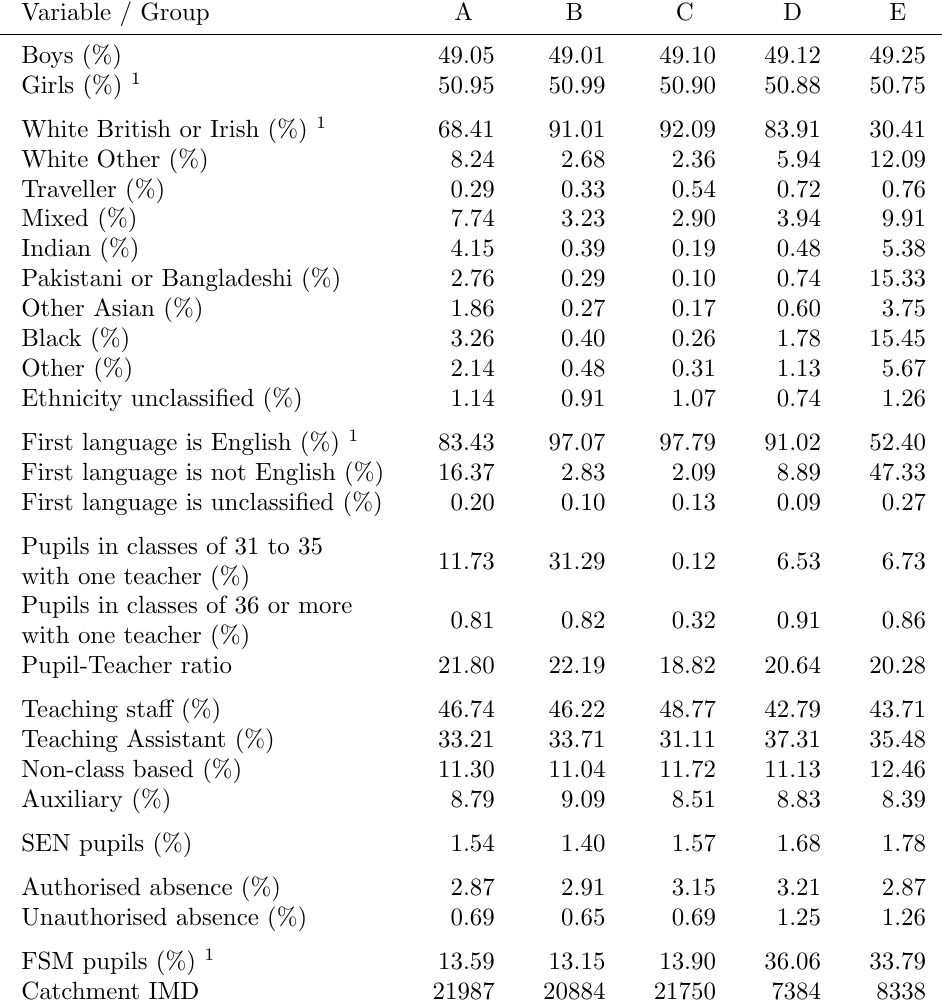
Table 1: Group centres on the raw